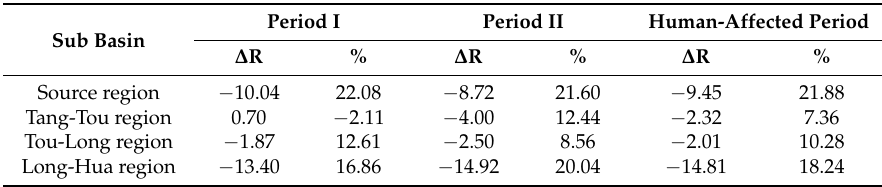
Table 6. Contribution of the variation of flood-season precipitation percentage in four regions of the